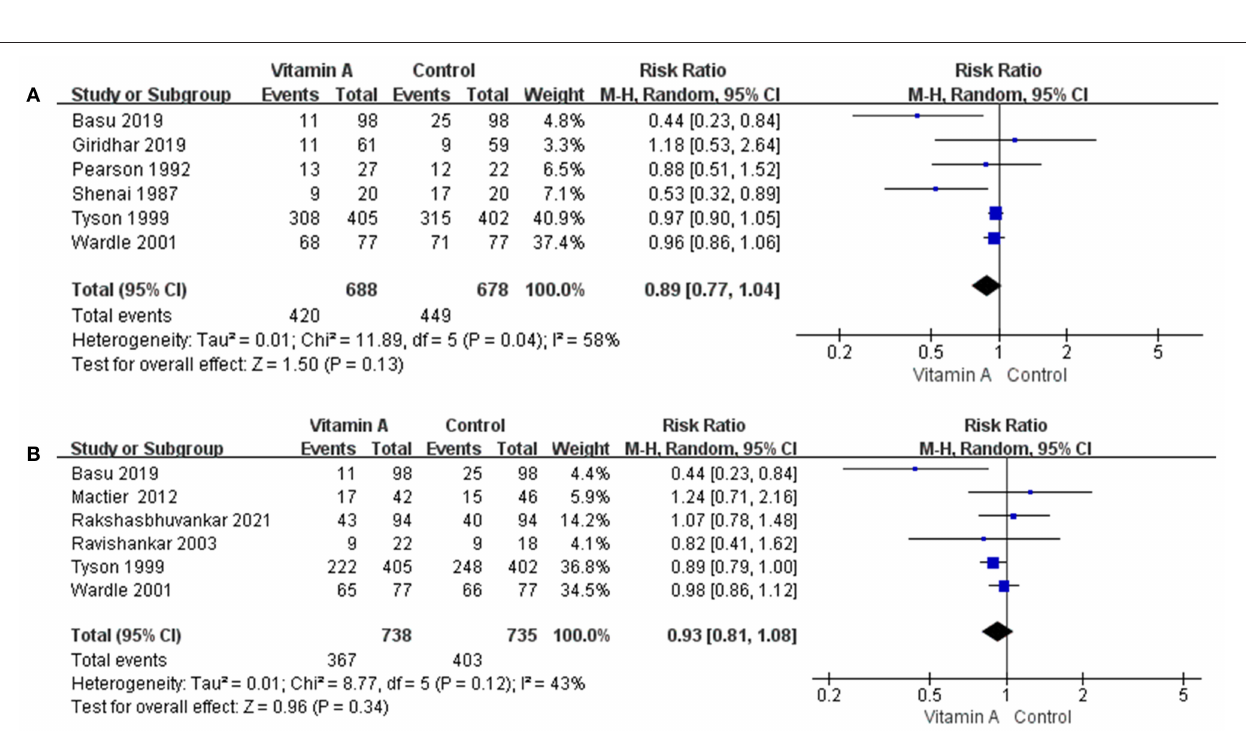
FIGURE 5 | The forest plot for the composite incidences of mortality and oxygen requirement. (A) The forest plot for the composite incidences of mortality and oxygen requirement before 1 month. (B) The forest plot for the composite incidences of mortality and oxygen requirement at 36 weeks’ PMA.